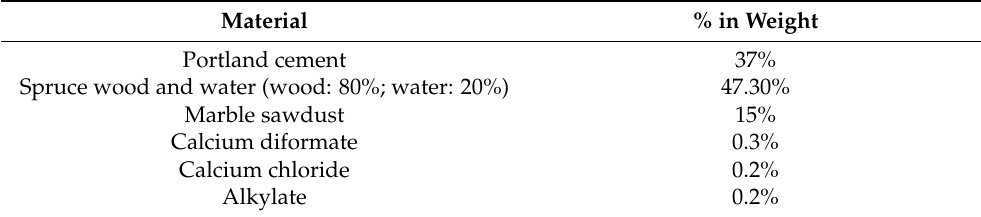
Table 16. Wood wool—percentage composition (1 kg of